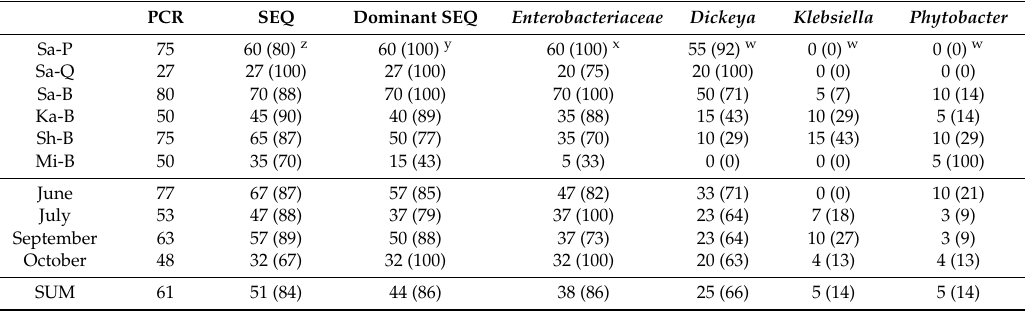
Table 2. Percentages of sweet potato tubers exhibiting PCR amplification for nifH , sequenced PCR fragments, PCR fragments with dominant nifH , and nifH genes similar to Enterobacteriaceae , Dickeya , Klebsiella , and Phytobacter . The same abbreviations as in Figure 1.